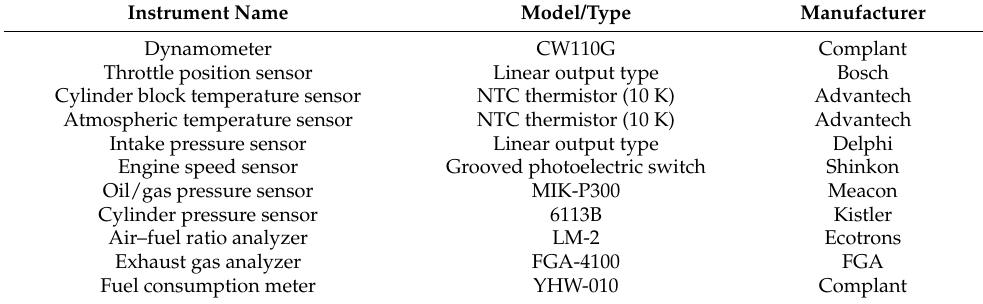
Table 5. Test equipment and instruments.